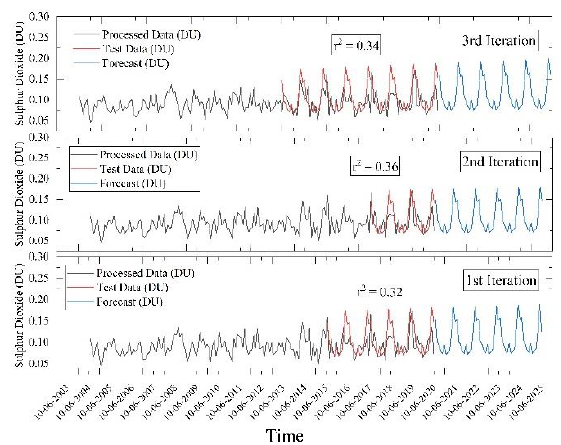
Figure 7: Forecast of Sulphur dioxide from year 2021 to 2025 using three iterations according to different training periods. First iteration uses 10 years data for training and 5 years as test. Second iteration uses 12 years data for training and 3 years as test. Third iteration uses 8 years data as training and 7 years as